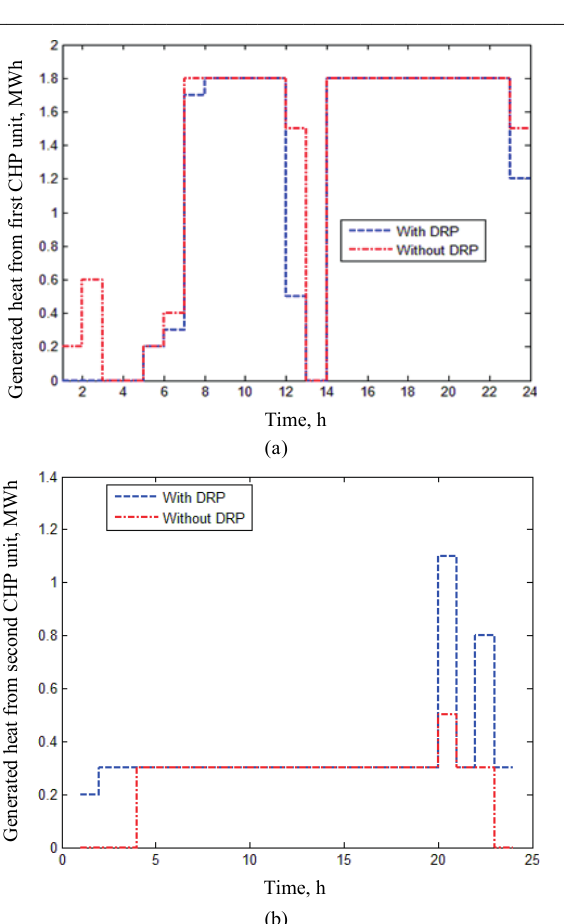
Fig. 7. Heat generated by CHP units: (a) CHP 1 and (b) CHP